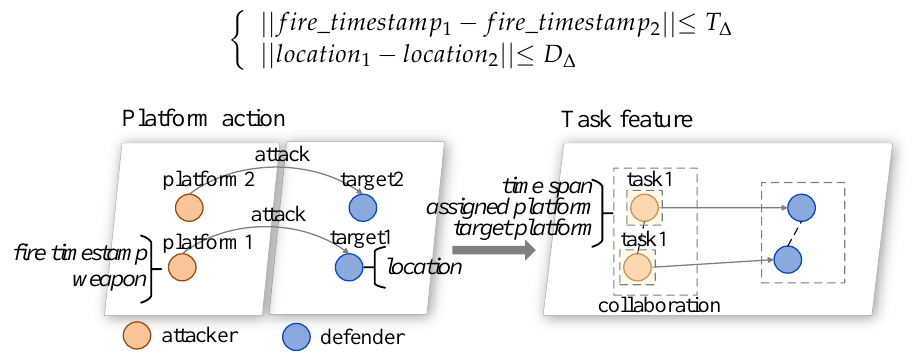
Figure 5. Task feature construction process based on platform actions.